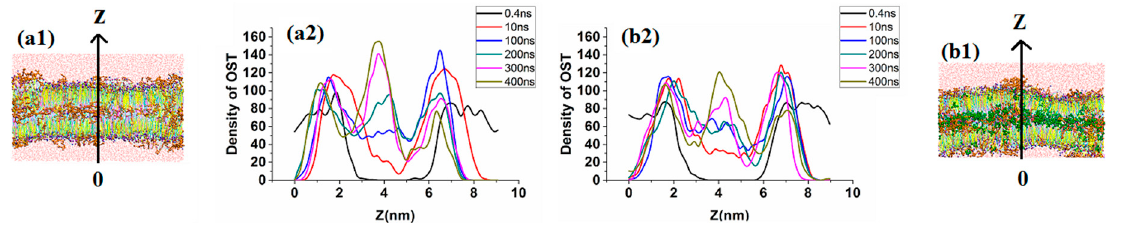
Figure 5. (1) Lateral views and (2) corresponding density profiles of osthole in z -axis direction in bilayer systems at different points in time by CG-MD simulations: ( a ) system without borneol; and ( b ) system with 5% borneol.